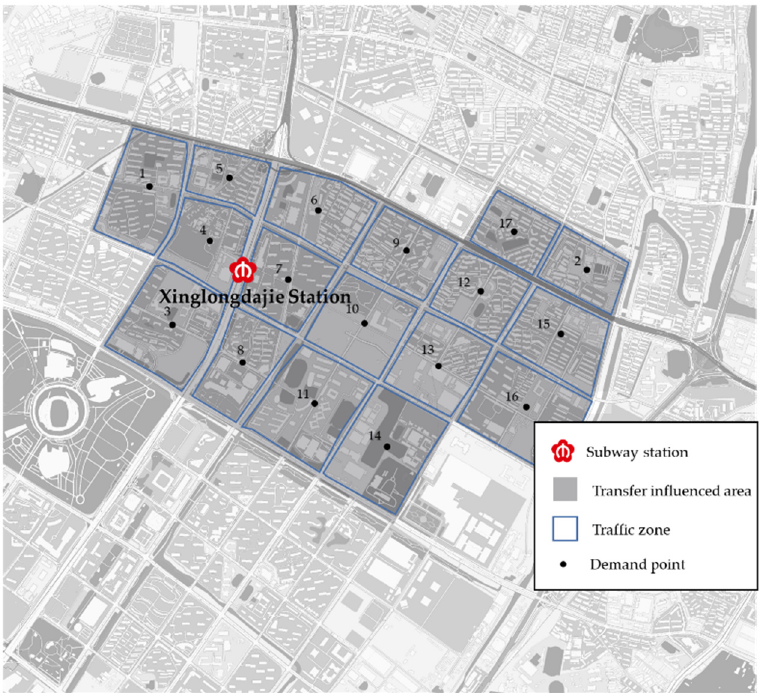
Figure 3. Distribution of the transfer-influenced area and traffic zones.